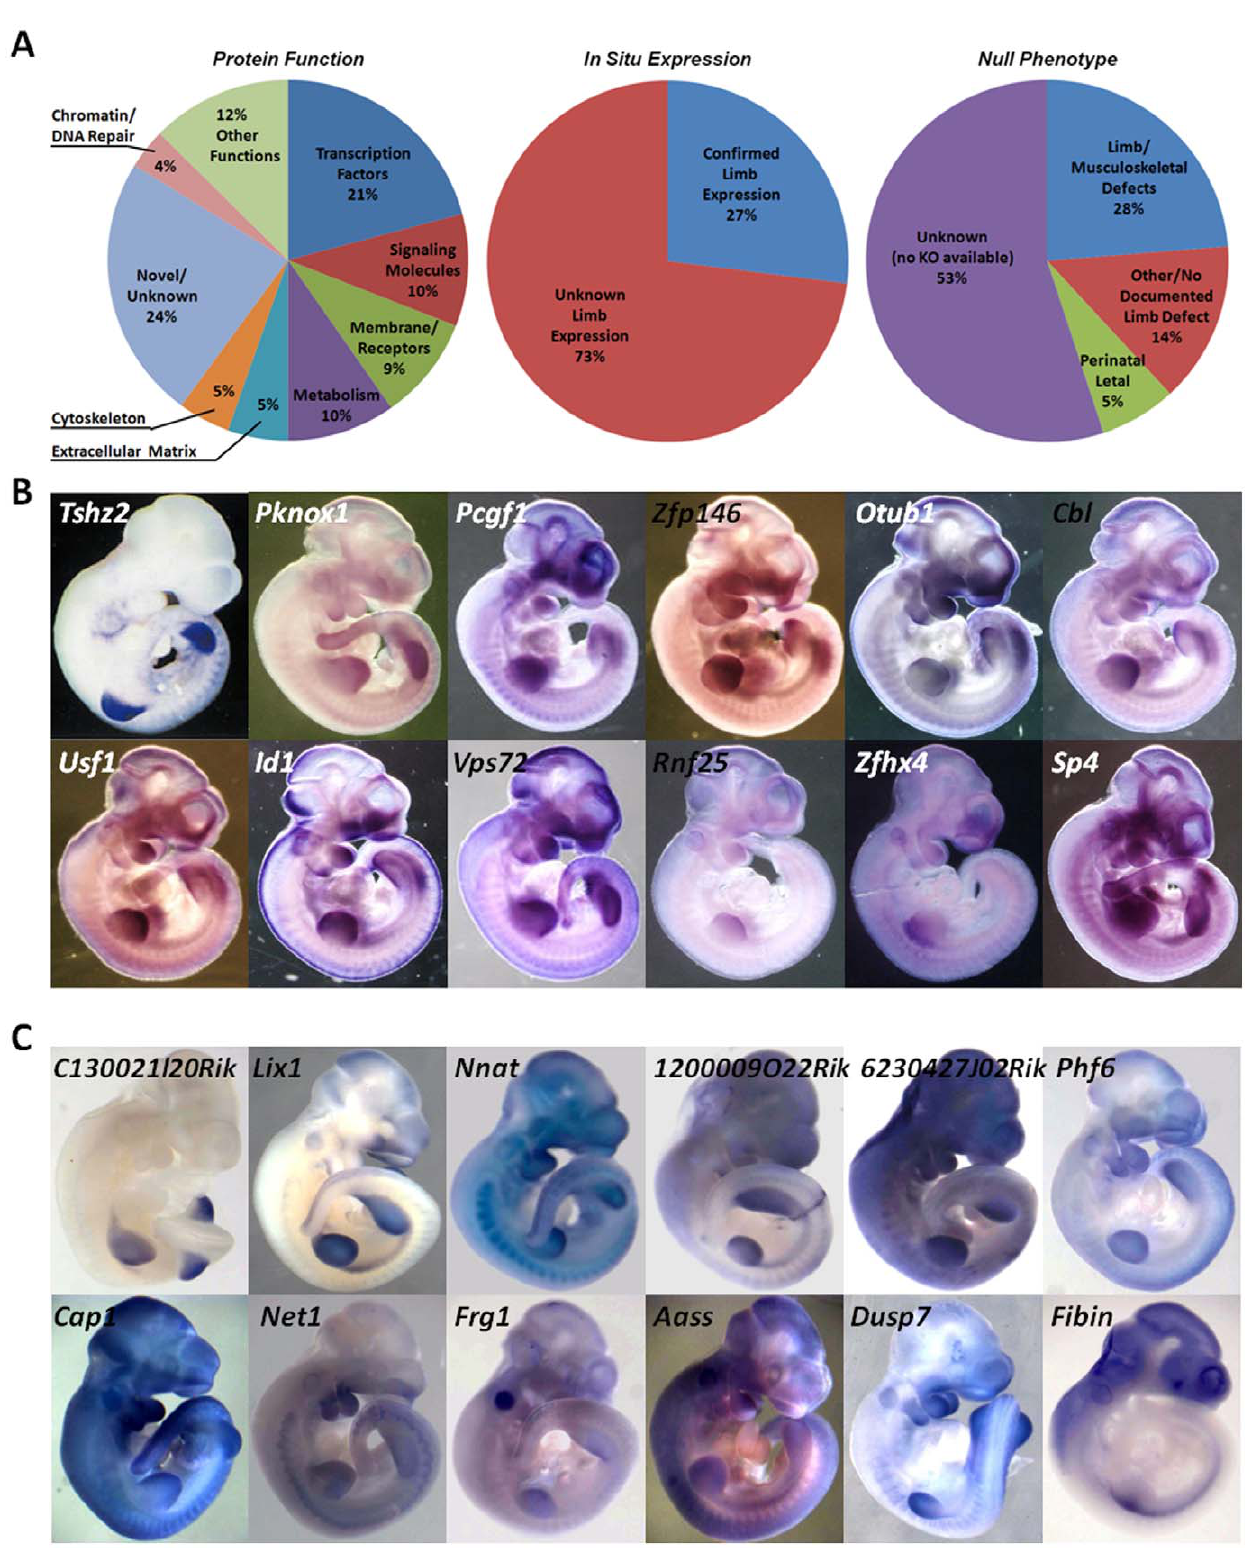
Figure 2. Analysis of the Top 100 Up-regulated Genes. 279 genes were examined for their putative protein function, available in situ expression in the limb, and description of null mouse phenotype (A). Most known genes previously uncharacterized in the limb with (B), or novel genes (C) showed unique and restrictive expression pattern in the limb. A survey of in situs of known genes with musculoskeletal defects in the knockout mouse are in Figure S1.